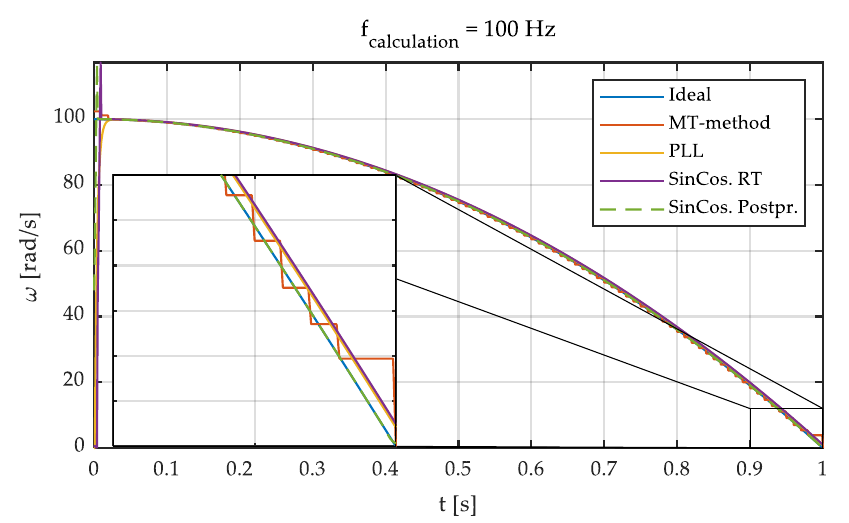
Figure 9. Simulation with different methods. d ω /d t = -200· t rad/s 2 . ω 0 = 100 rad/s.